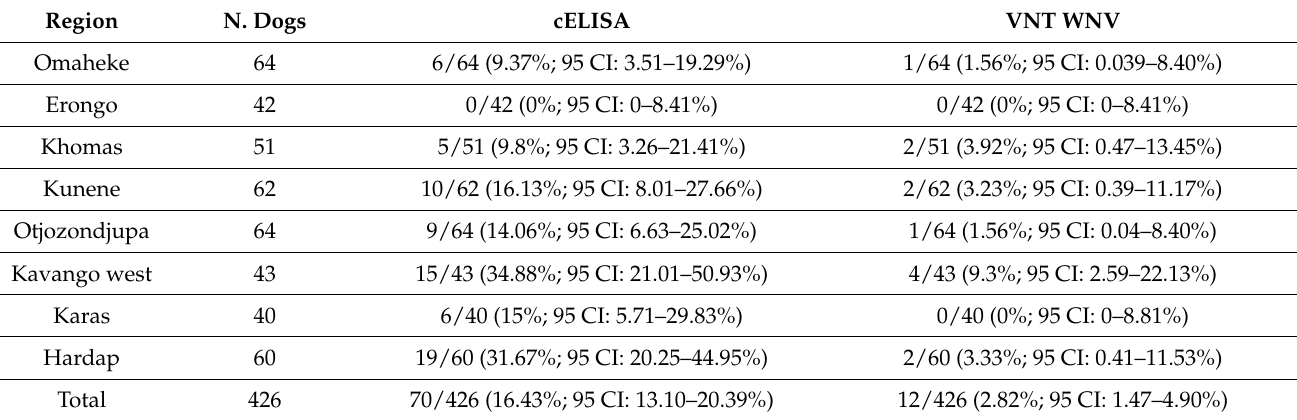
Table 1. Seroprevalence of WNV in dogs according to Namibian